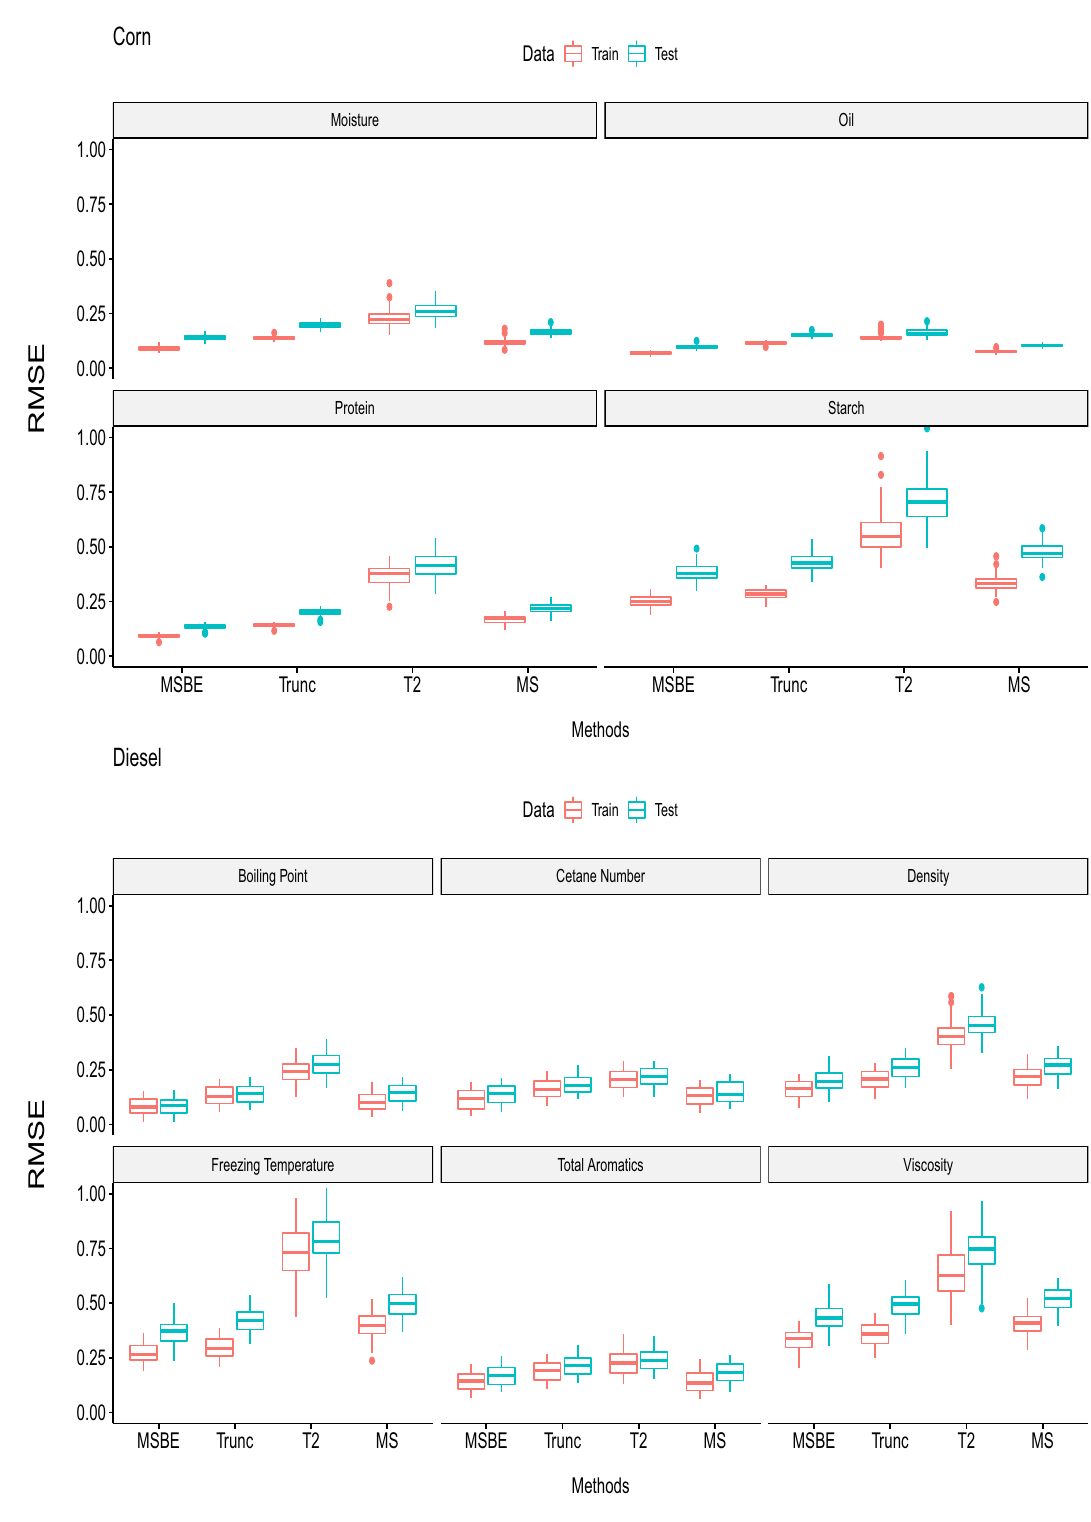
Figure 4. The distribution of train and test RMSEP together with standard error bars is presented for all fitted model of corn and diesel contents. Trends are extracted based on the 100 Monte Carlo